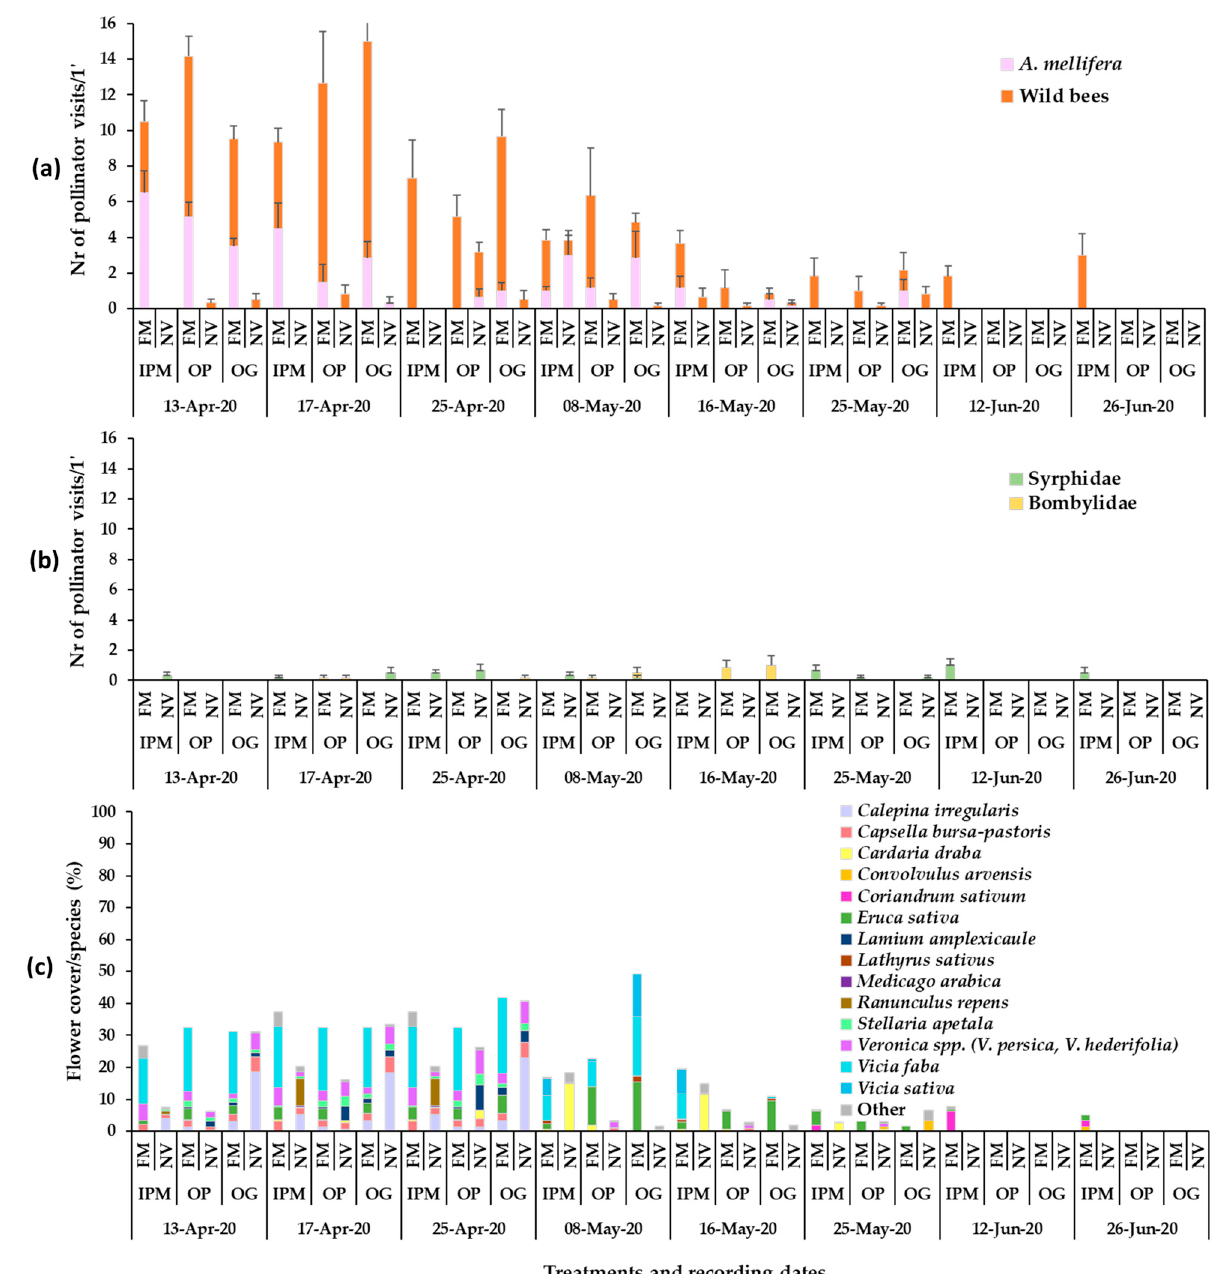
Figure 2. Mean numbers of ( a ) Hymenoptera pollinator visits (honey bees, wild bees) and ( b ) Diptera visits on ground cover patches (1 min/6.4 m 2 ) in apple orchards and ( c ) mean flower cover percentage per plant species in the patches in year 2020. FM: sown flowering mixture; NV: natural vegetation (wild plants); IPM: IPM orchard, OP: organic palmette orchard, OG: organic goblet orchard. Vertical bars represent standard error of means. Other species: Brassica nigra , Cardamine hirsuta , Geranium disectum , Malva spp., Matricaria chamomila , Medicago polymorpha , Poa annua , Raphanus sp., Senecio vulgaris , Sonchus oleraceus , Taraxacum officinale , Trifolium repens , Cerastium glomeratum , Draba muralis , Euphorbia sp., Galium aparinae , Lythospermum arvense .